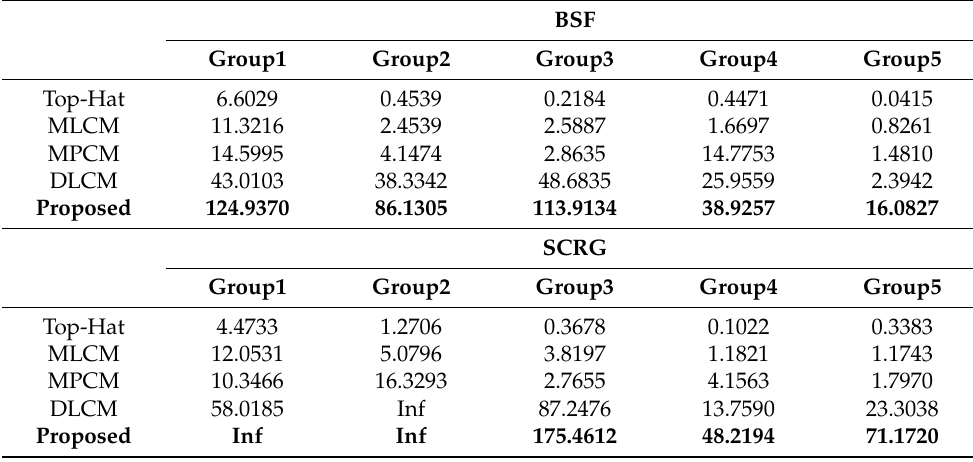
Table 2. BSF and SCRG of different algorithms.